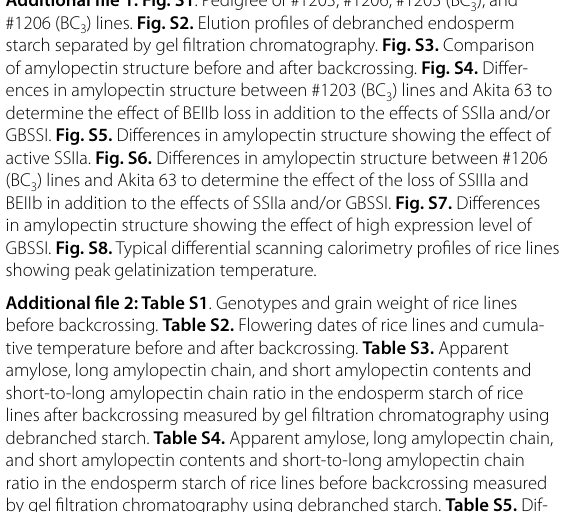
Additional file 2: Table S1 . Genotypes and grain weight of rice lines before backcrossing. Table S2. Flowering dates of rice lines and cumula- tive temperature before and after backcrossing. Table S3. Apparent amylose, long amylopectin chain, and short amylopectin contents and short-to-long amylopectin chain ratio in the endosperm starch of rice lines after backcrossing measured by gel filtration chromatography using debranched starch. Table S4. Apparent amylose, long amylopectin chain, and short amylopectin contents and short-to-long amylopectin chain ratio in the endosperm starch of rice lines before backcrossing measured by gel filtration chromatography using debranched starch. Table S5. Dif- ferential scanning calorimetry analysis of the thermal properties of starch in rice lines before backcrossing. Table S6. RS contents of raw and cooked rice flour and un-mashed and mashed cooked rice